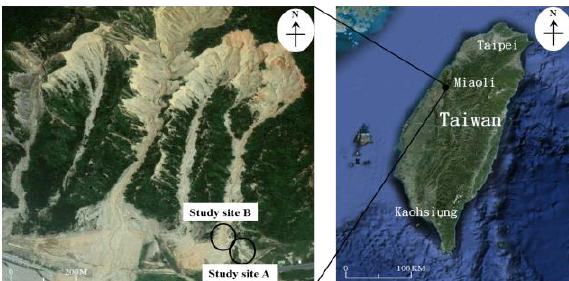
Figure 3. Map of study sites at the Huoyen Shan in Miaoli County